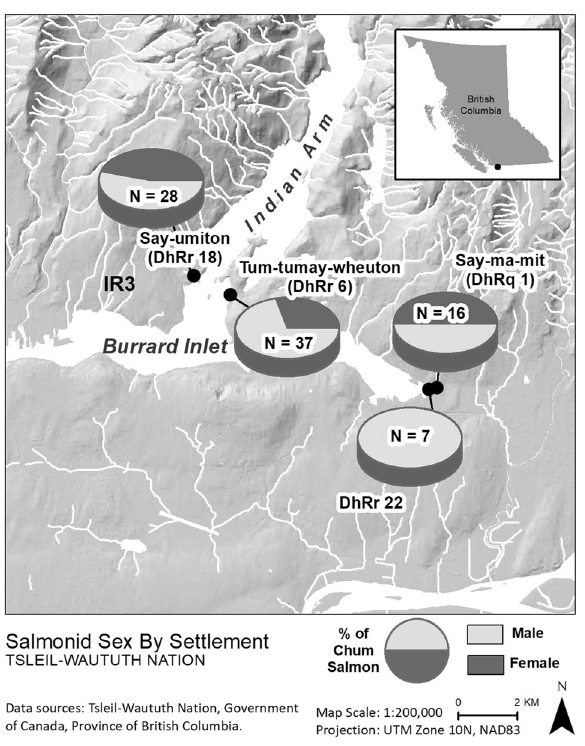
Figure 5. Proportion of male and female chum salmon at the sampled archaeological sites. Figure created in ESRI ArcGIS version 10.8.1 (https:// www. esri.